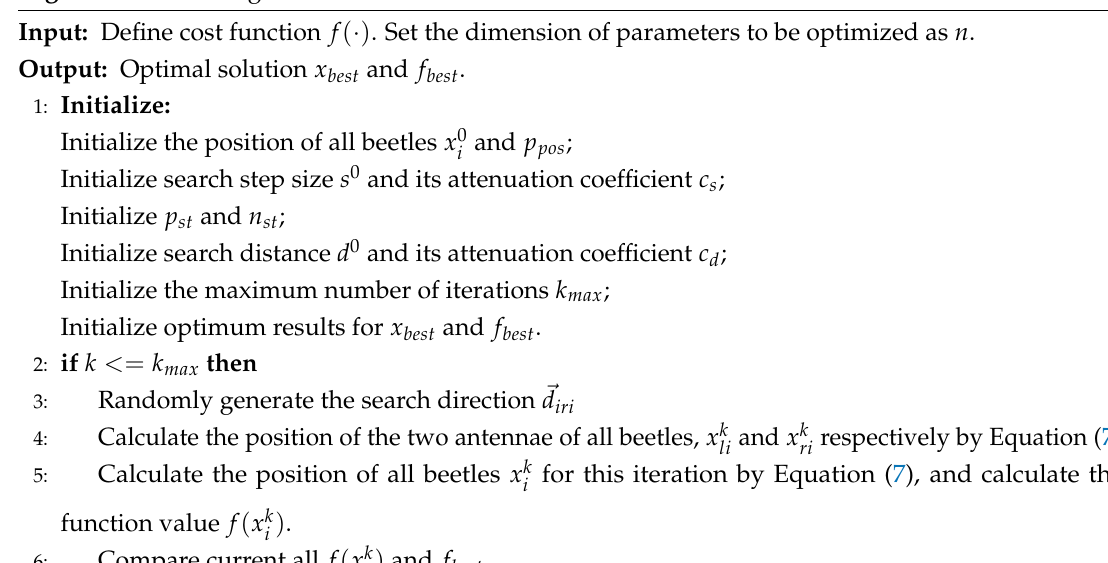
Algorithm 2 BSAS